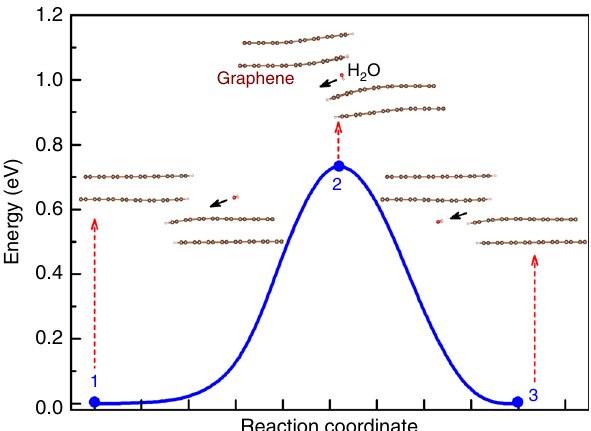
Fig. 7 Water permeation energy required for water vapour passage through overlapping grain boundaries in graphene. The minimum energy pathways of the H 2 O migration through the channels created by two overlapping grain boundaries in multilayer graphene sheets. Simulation results show that suf fi cient energy needs to be supplied to the graphene fi lm in order for water vapour permeation to occur through the graphene channels, which is supplied in the form of heat in the desalination of water molecules and rejection of salt ions through the graphene layers. The simulation domain and molecular construct of the permeable graphene-based membrane are shown in Figs. 8a, b. Three feed solutions are considered in this study: water with 120 − 1 − 1 of sodium chloride (NaCl), water with 120 g L of NaCl g L and one molecule (5 mM) of SDS, and fi nally water with 120 g L − 1 of NaCl and two molecules (10 mM) of SDS. Higher concentra- tions of NaCl are used in the simulations as compared to the experiments to ensure suf fi cient interactions of the salt ions with the membrane, given the very short simulation time of 4 ns. Here, one or two SDS molecules are added in the feed, as the experimental scenario of 1 mM of SDS corresponds to either a single- or bi-molecular state of SDS 29 .